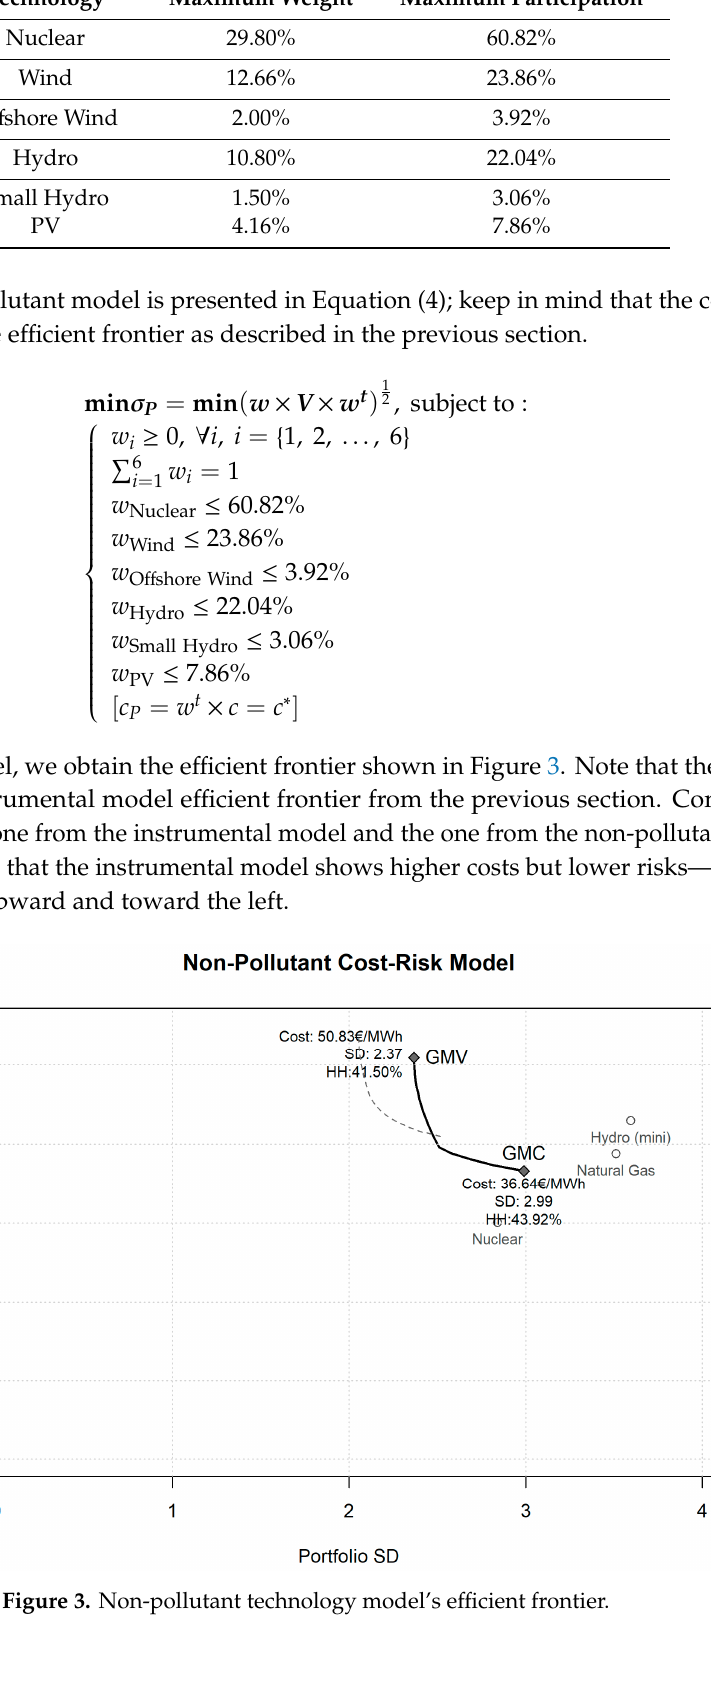
Table 4. Non-pollutant technological and environmental limits. Source: Authors' own work, based on data collected from DeLlano et al. (2015) [14].